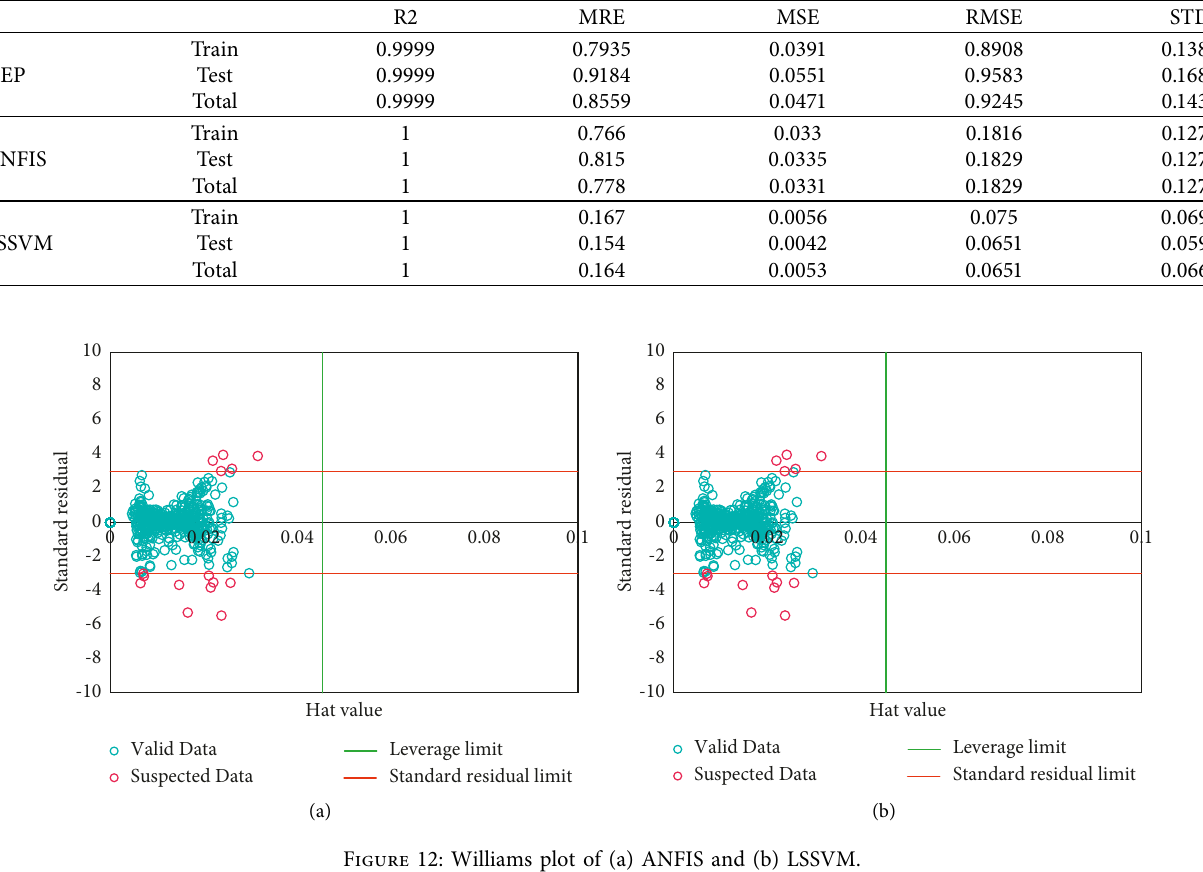
Table 2: The statistical indexes for suggested models.